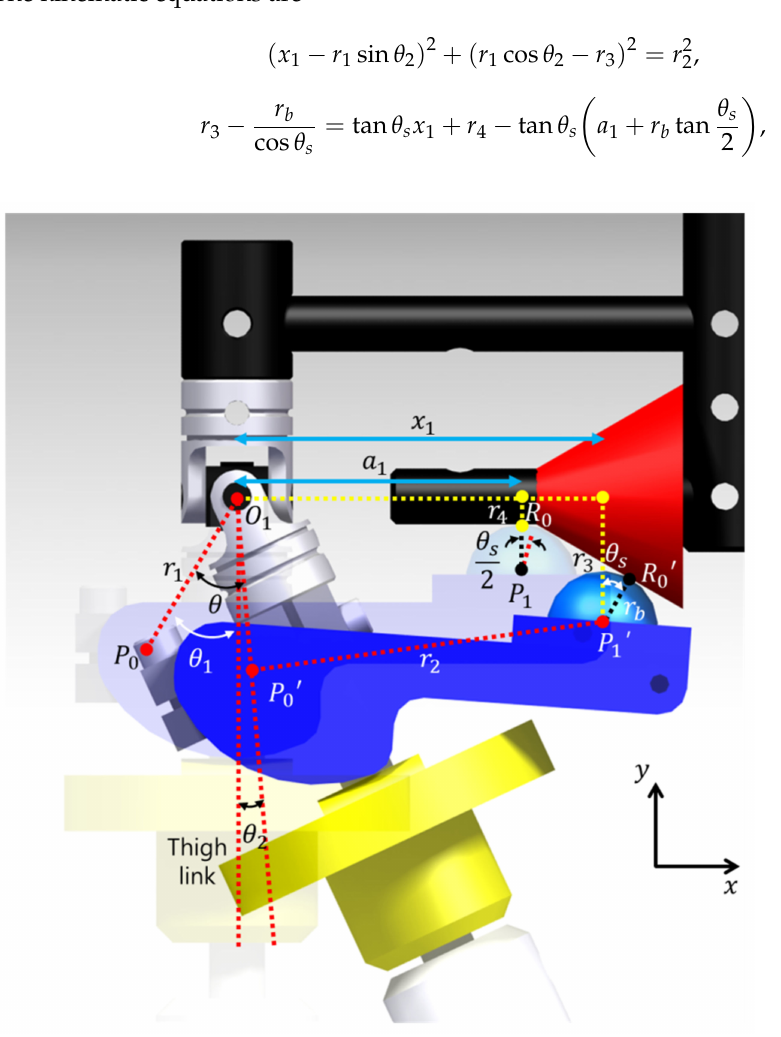
Figure 2. Kinematic system in the proposed exoskeleton. Therefore, x 1 and r 3 are defined using Equations (1) and (2). Here r 1 represents O 1 P 0 , P (cid:48) and r 2 represents P (cid:48) . r 3 represents the y -axis distance from O 1 to P (cid:48) , and r 4 represents 1 0 1 the y -axis distance from O 1 to R 0 . r b represents the radius of the ball. a 1 represents the x -axis distance from O 1 to P 1 when the hip adduction angle ( θ ) is 0 rad, and x 1 represents the x -axis distance from O 1 to P (cid:48) when the hip adduction angle is θ rad ( θ (cid:54) = 0 rad). 1 Figure 3 shows the force generated at the joint and contact point when the exoskele- ton’s hip adduction angle is θ . Q 0 represents the contact point of the cam and follower, and S 0 represents the cam’s center of mass. S 1 represents the pelvic link’s center of mass. l G O 1 S 1 , and l G , cam represents P (cid:48) S 0 . F x x -axis reaction , pelvis represents , hip represents the 0 force generated in O 1 , F y , hip represents the y -axis reaction force generated in O 1 , and τ z , hip represents the z -axis reaction torque generated in O 1 . F x , cam represents the x -axis reaction force generated in P (cid:48) , and F y , cam represents the y -axis reaction force generated in P (cid:48) . F cam 0 0 represents the weight of the cam acting on S 0 . F spring represents the spring force acting on Q 0 . F ball represents the reaction force generated at R (cid:48) . F load represents the weight 0